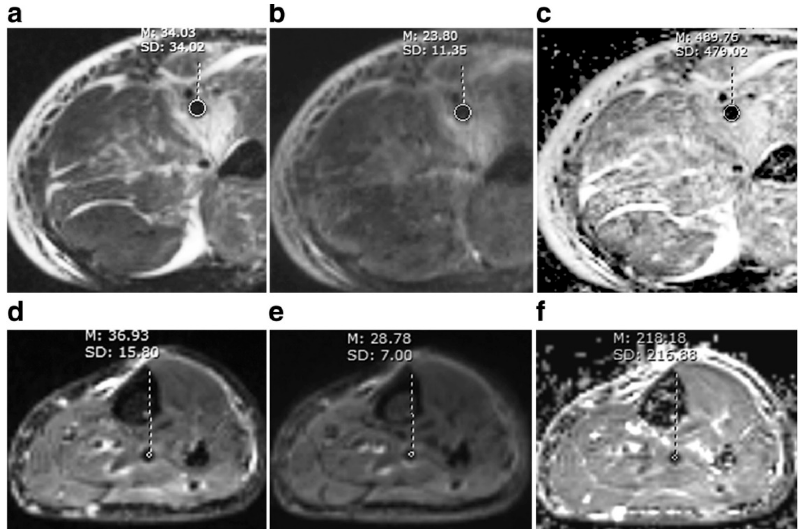
Figure 20. A comparison between acute and non-acute DVT. Acute thrombus (first line) and non-acute thrombus (second line) were hypointense on b = 0 ( a , d ), b = 800 s / mm2 ( b , e ) image. The signal intensity was about the same for acute and non-acute thrombus, while ADC values di ff ered greatly ( c , f ). Mean ADC of this acute thrombus was above the cut-o ff of 0.32 × 10 − 3 mm 2 / s, while that of non-acute thrombus was below the cut-o ff . Reproduced with permission from We et al., 2019